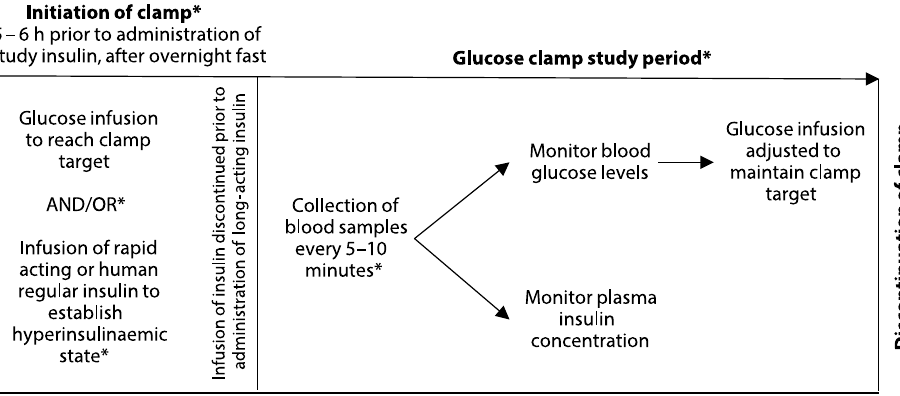
Figure 1: Euglycemic clamp methodology. Figure 1. Euglycemic clamp